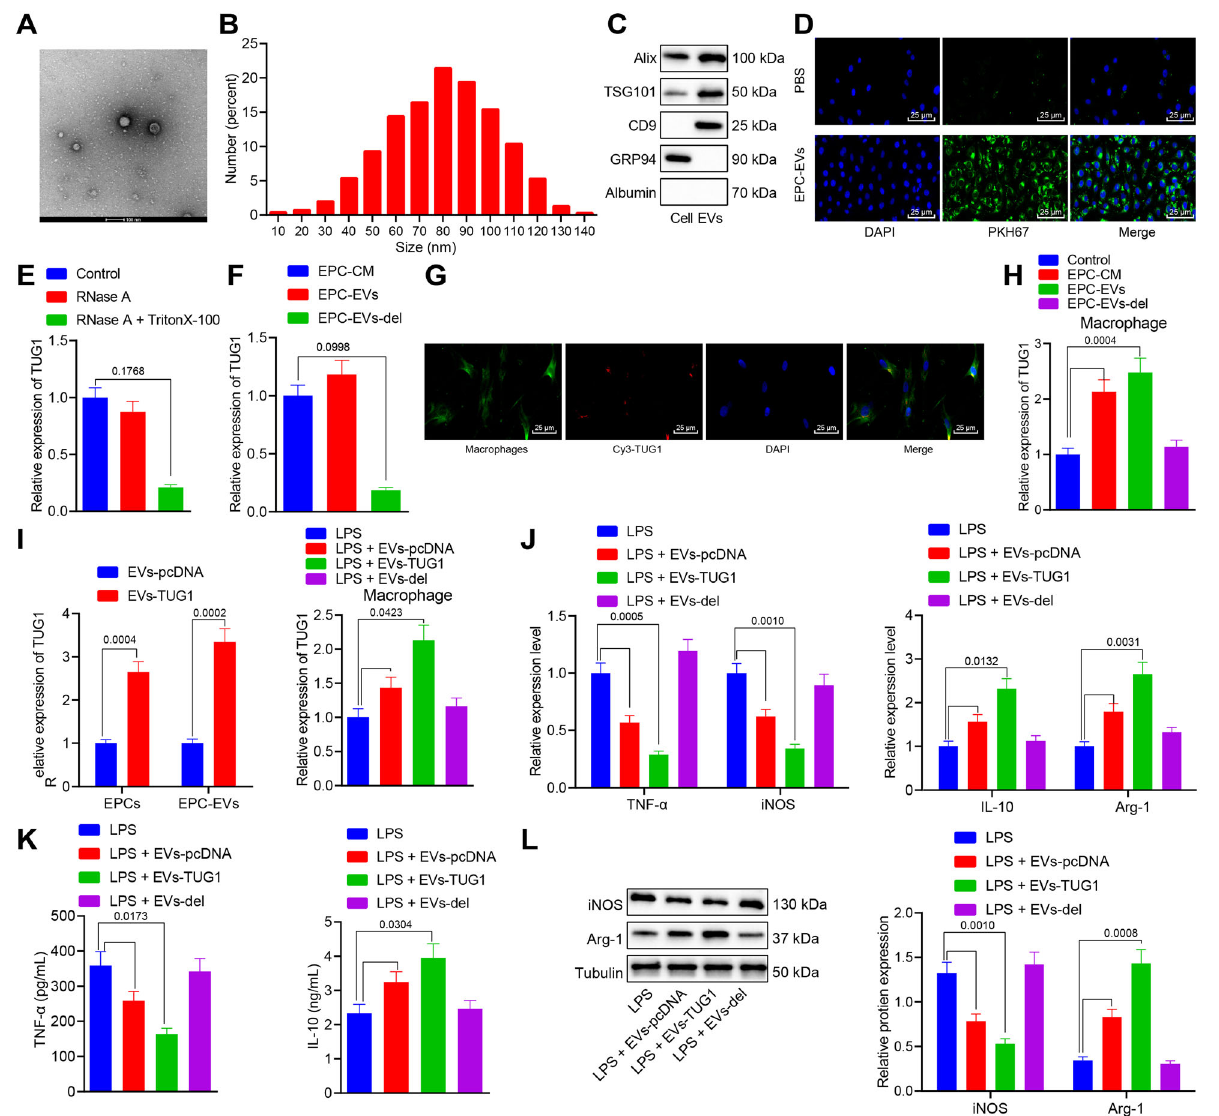
Fig. 3 TUG1 in EPCs can be transmitted to macrophages through EVs and then promotes macrophage M2 polarization. A Particle diameter of EPC-derived EVs (bar = 100 nm). B The diameter distribution and concentration of EVs detected by NTA. C Western blot analysis for determination of protein expression of ALIX, TSG101, CD9, GRP94, and albumin. D Uptake of EPC-derived EVs labeled with fl uorescent PKH67 by macrophages observed by immuno fl uorescence microscopy. The PKH67-labeled EVs were red-colored and the DAPI-stained nuclei were blue (scale bar = 25 μ m). E The level of TUG1 measured by RT-qPCR after RNase treatment alone. F The expression of TUG1 in EPCs derived EVs and EPC medium determined by RT-qPCR. G Uptake of EPC-derived EVs labeled with Cy3-TUG1 by macrophages observed by immuno fl uorescence microscopy. The Cy3-TUG1 labeled EVs were red, the DAPI-stained nuclei were blue, and phalloidin labeled macrophages were green (scale bar = 25 μ m). H The expression of TUG1 in macrophages cocultured with EPCs derived EVs determined by RT- qPCR. I The expression of TUG1 in EPCs and EPCs derived EVs after pcDNA TUGq-transfected EPCs cocultured with macrophages assessed by RT-qPCR. J RT-qPCR for measurement of mRNA expression of iNOS, TNF- α , IL-10, and Arg-1 in macrophages cocultured with EPCs derived EVs. K The contents of IL-10 and TNF- α protein in the cell culture medium evaluated by ELISA. L The protein expression of iNOS and Arg-1 in macrophages cocultured with EPCs derived EVs measured by western blot analysis. Measurement data were expressed as mean ± standard deviation. Data between two groups were compared using unpaired t -test. One-way ANOVA was adopted for comparison between multiple groups followed by Tukey ’ s post hoc test. Cell experiments were conducted three times independently. * p < 0.05 vs. cells, control, EPC-CM, EVs-pcDNA, or LPS